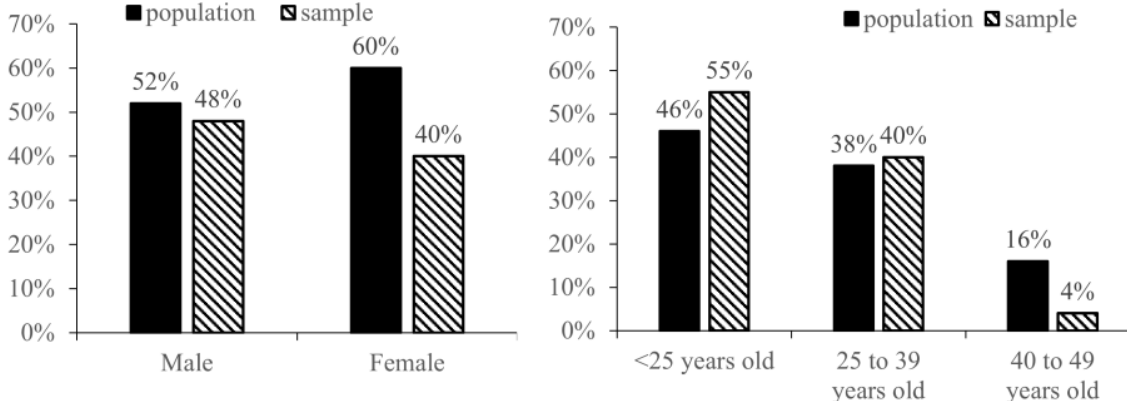
Figure 1 Demographics of sample and Egyptian